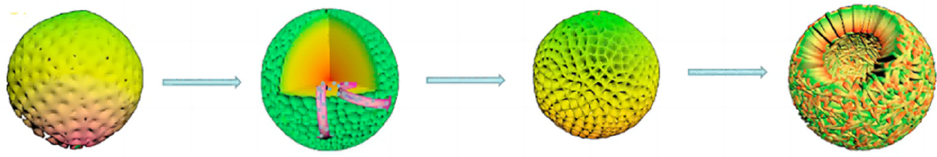
Figure 10. Schematic diagram of the HNWM formation process [68].